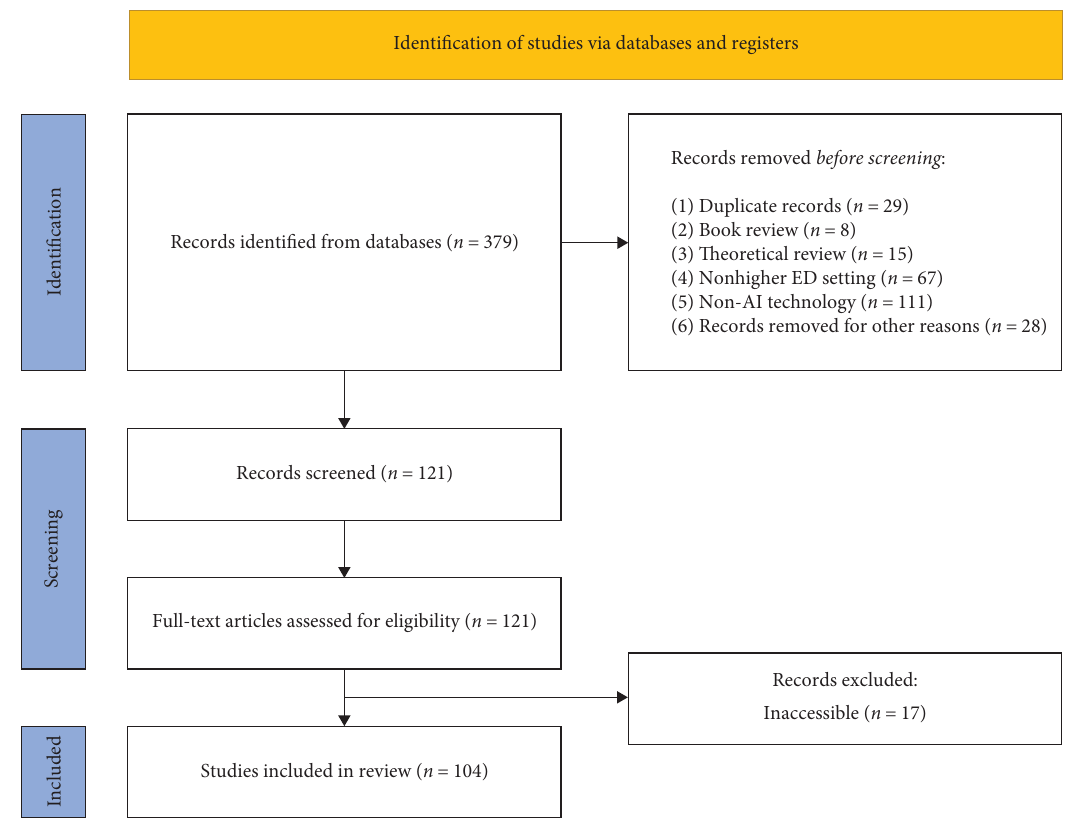
F IGURE 1: PRISMA fl owchart for the selection process of the